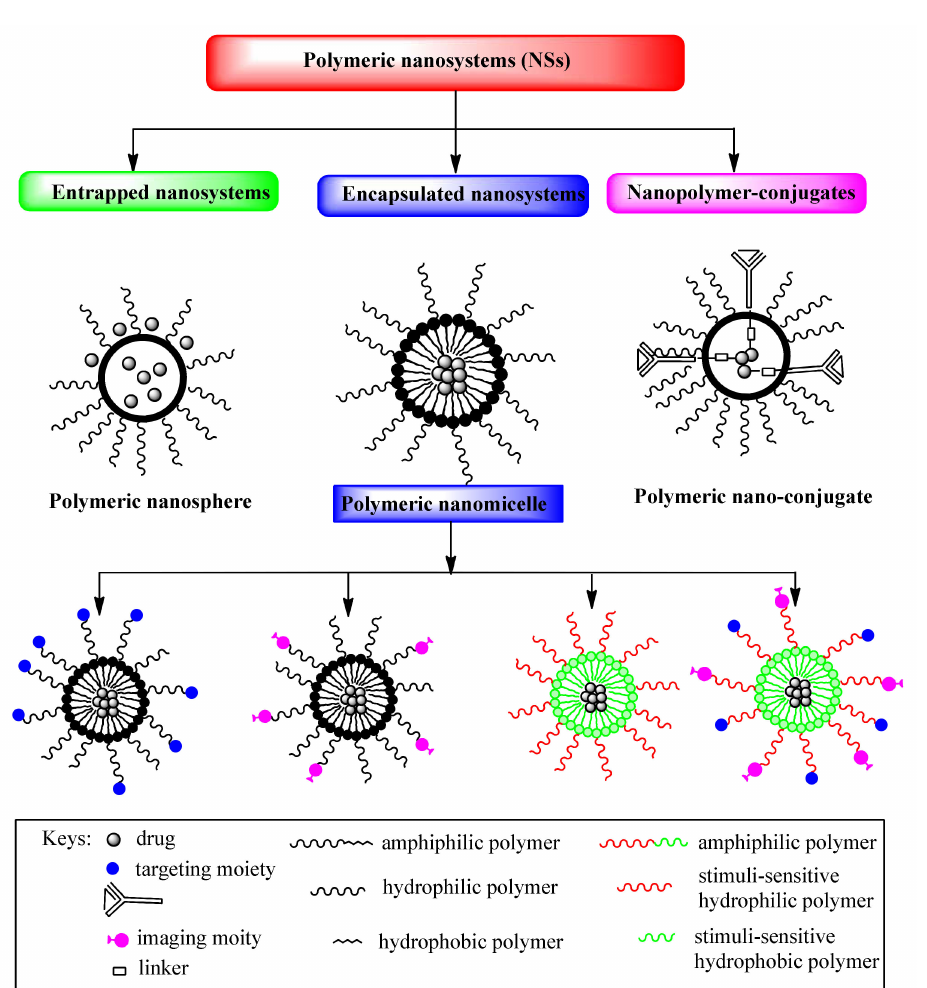
Figure 1. Schematic illustration of multifunctional drug delivery